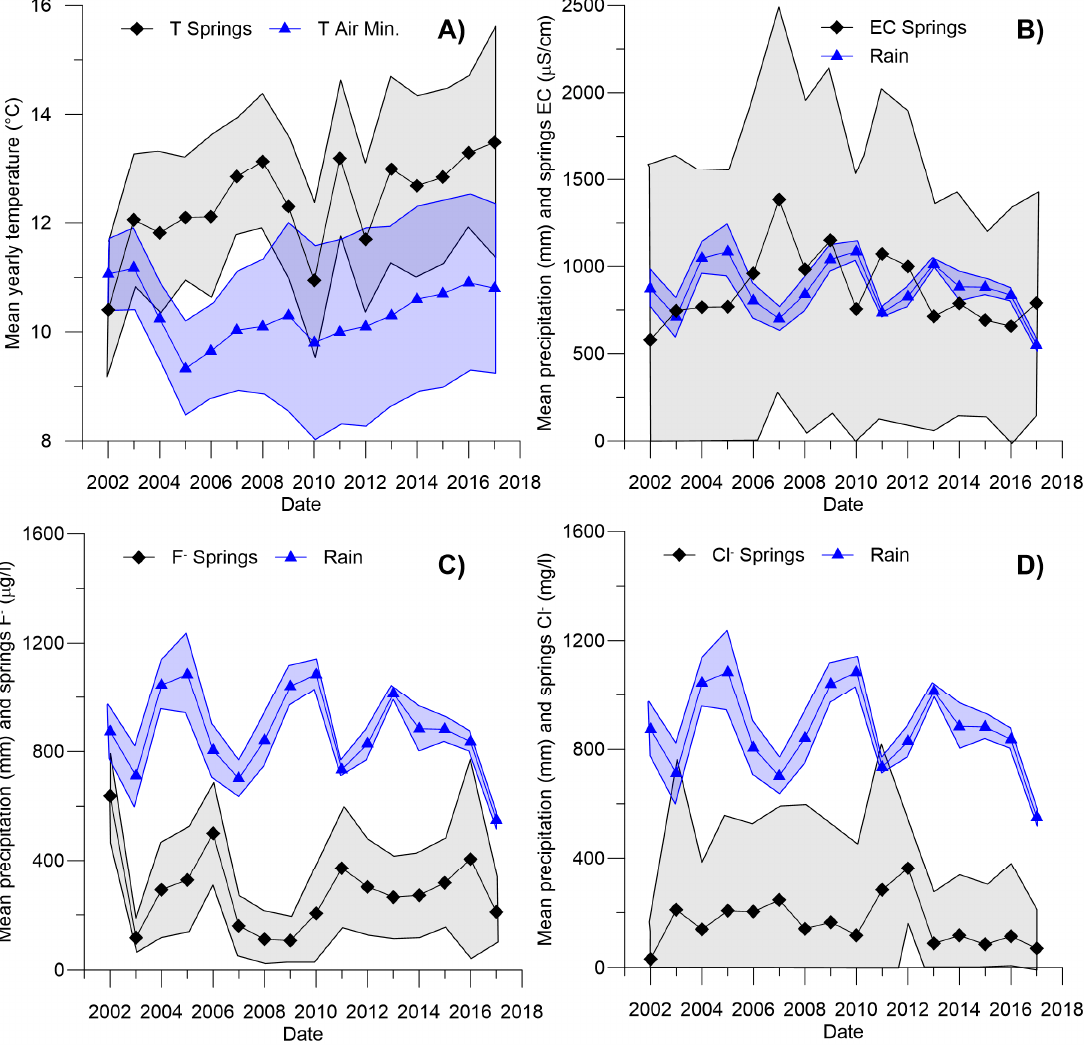
Figure 6. ( A ) Annual average spring water temperatures recorded from 2002 to 2017 (black diamonds), compared with the average minimum air temperatures (blue triangles) and their standard deviations (shaded areas). ( B ) Annual average spring water EC (black diamonds), compared with the mean precipitations (blue triangles) and their standard deviations (shaded areas). ( C ) Annual average spring water F – concentration (black diamonds), compared with the mean precipitation (blue triangles) and their standard deviations (shaded areas). ( D ) Annual average spring water Cl – concentration (black diamonds), compared with the mean precipitations (blue triangles) and their standard deviations (shaded areas).